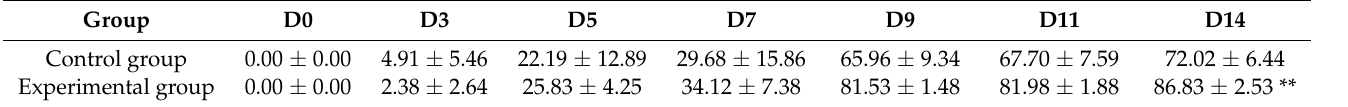
Figure 4. Wound healing status on D3, D7, and D14. Table 3. Wound healing rate in rats ( x s ± d).